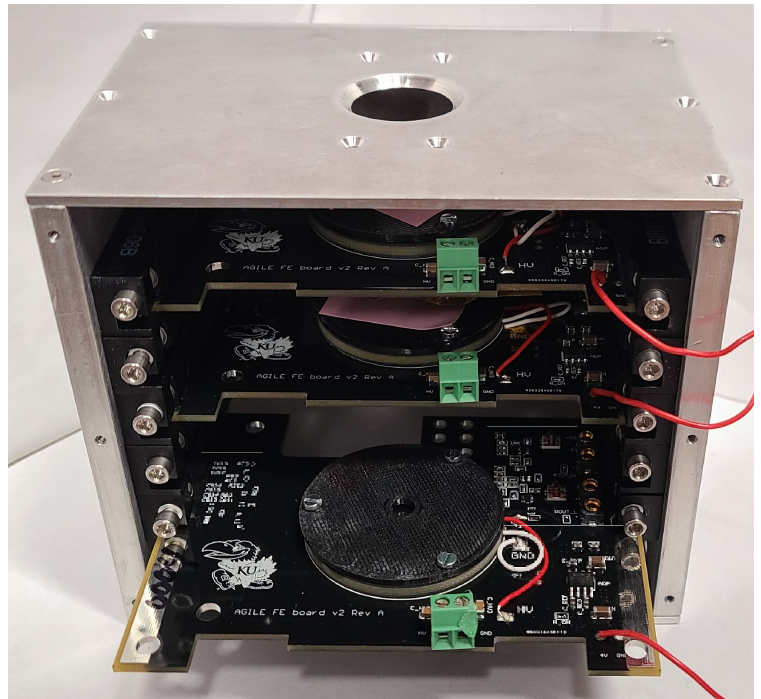
Figure 4. A photograph of the CubeSat mock-up used in the laboratory